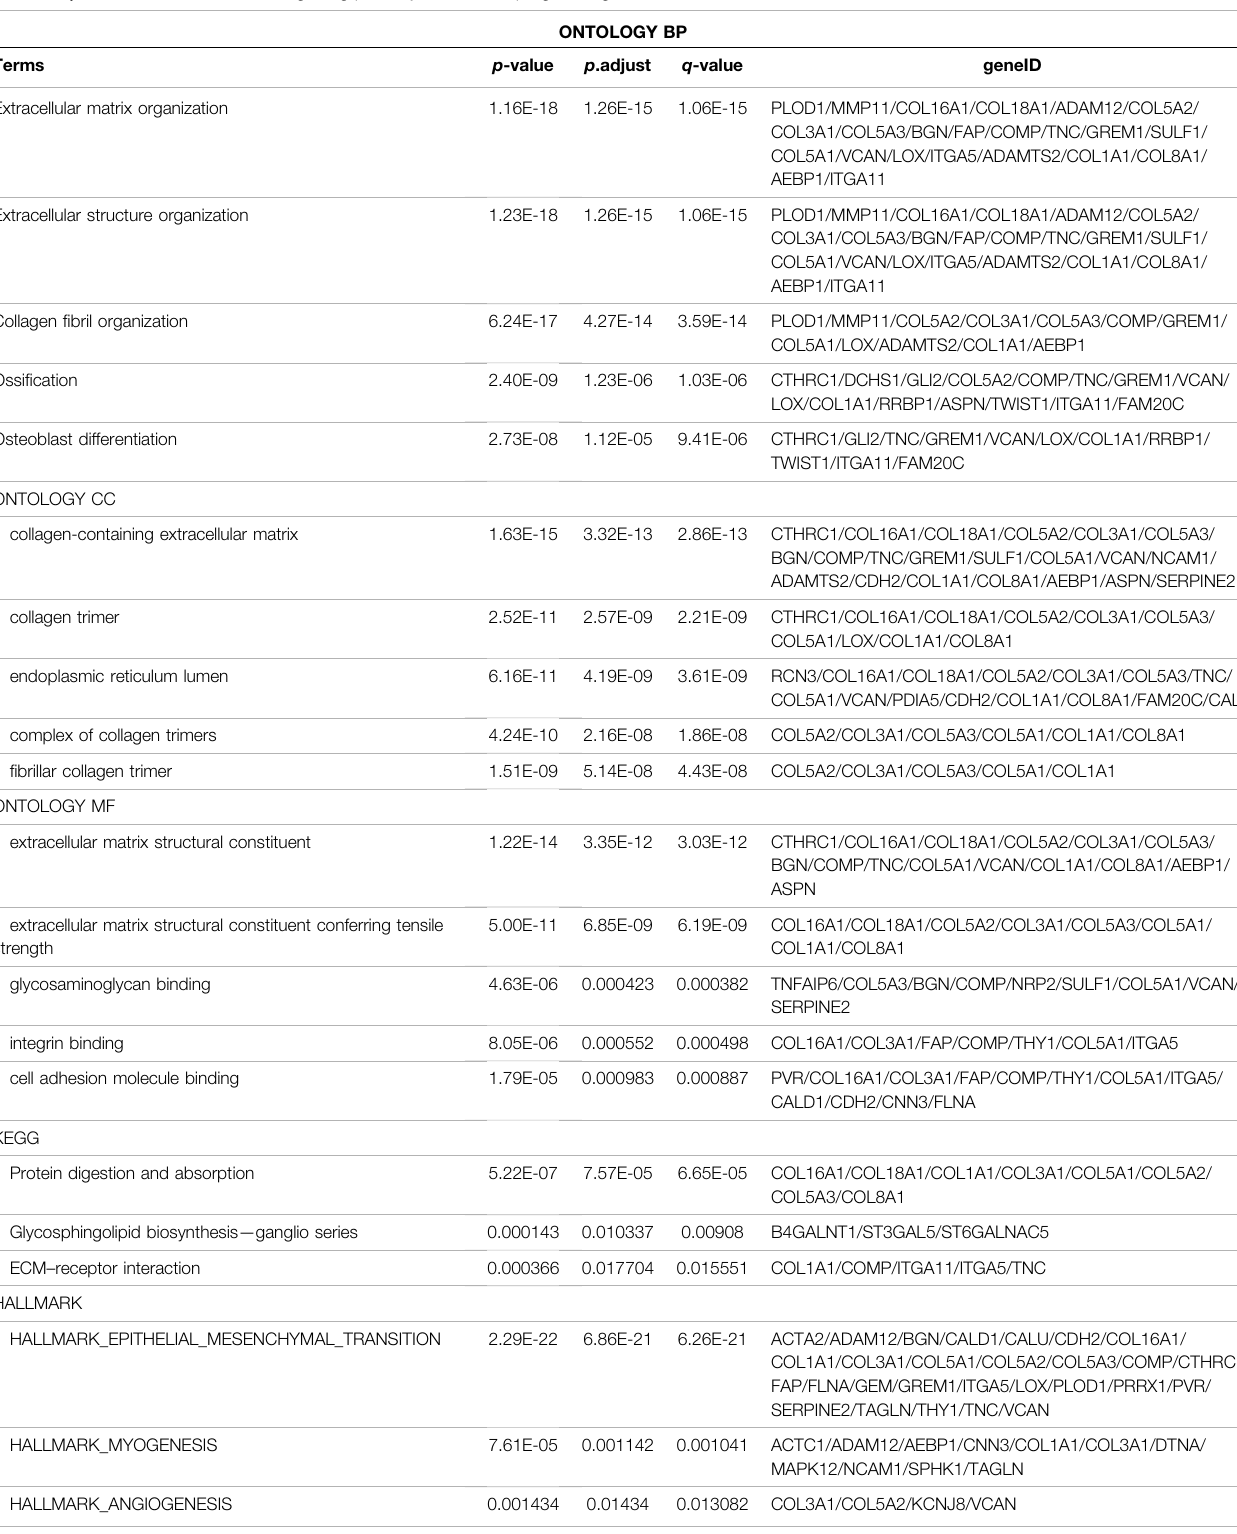
TABLE 1 | The details of the enriched signaling pathways of the 107 prognostic